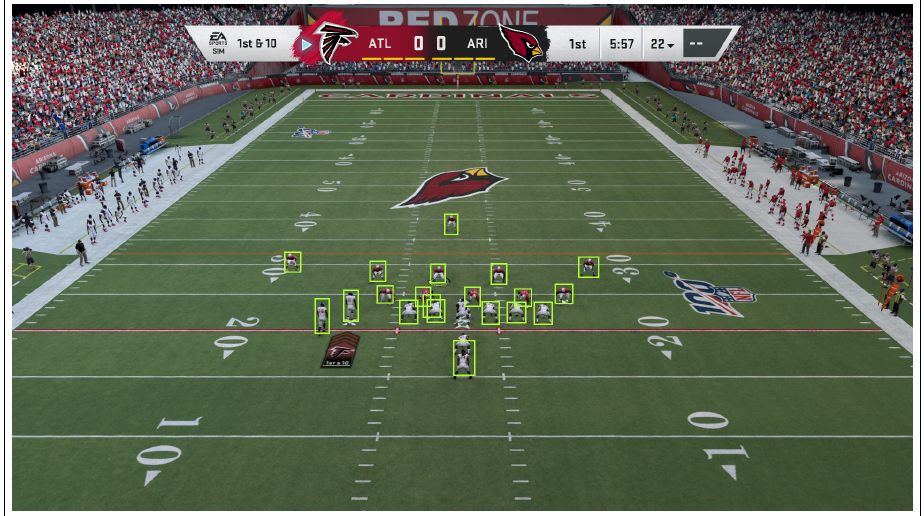
Figure 16. The output from the player localization module fails in a case that would affect the number of defensive linemen. There is an extra player identified on the left between an offensive and defensive player, thus motivating the evaluation of the offensive line rule. Occlusion is also evident in this image for one of the linemen in the center of the